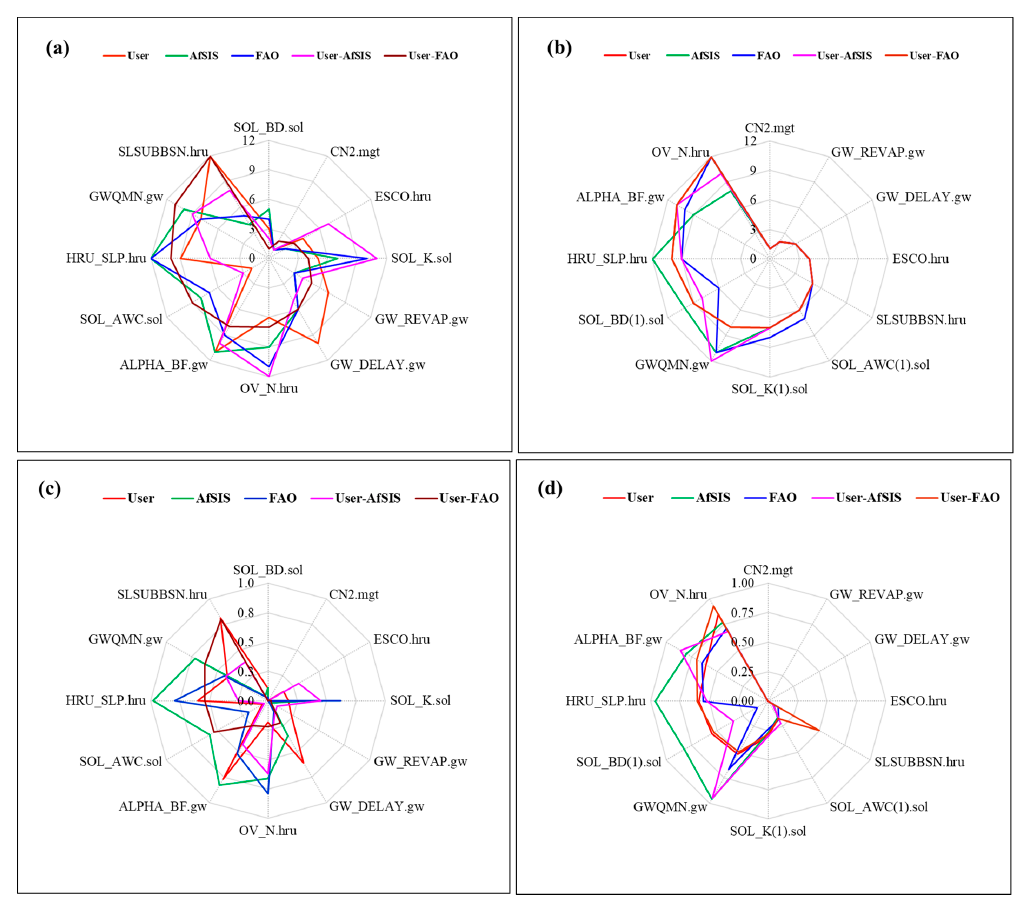
Figure 9. Sensitivity analysis of SWAT model calibration parameters based on the five soil datasets ( a , b ) parameter rank and ( c , d ) t-statistics p-values for daily and monthly calibrations, respectively.